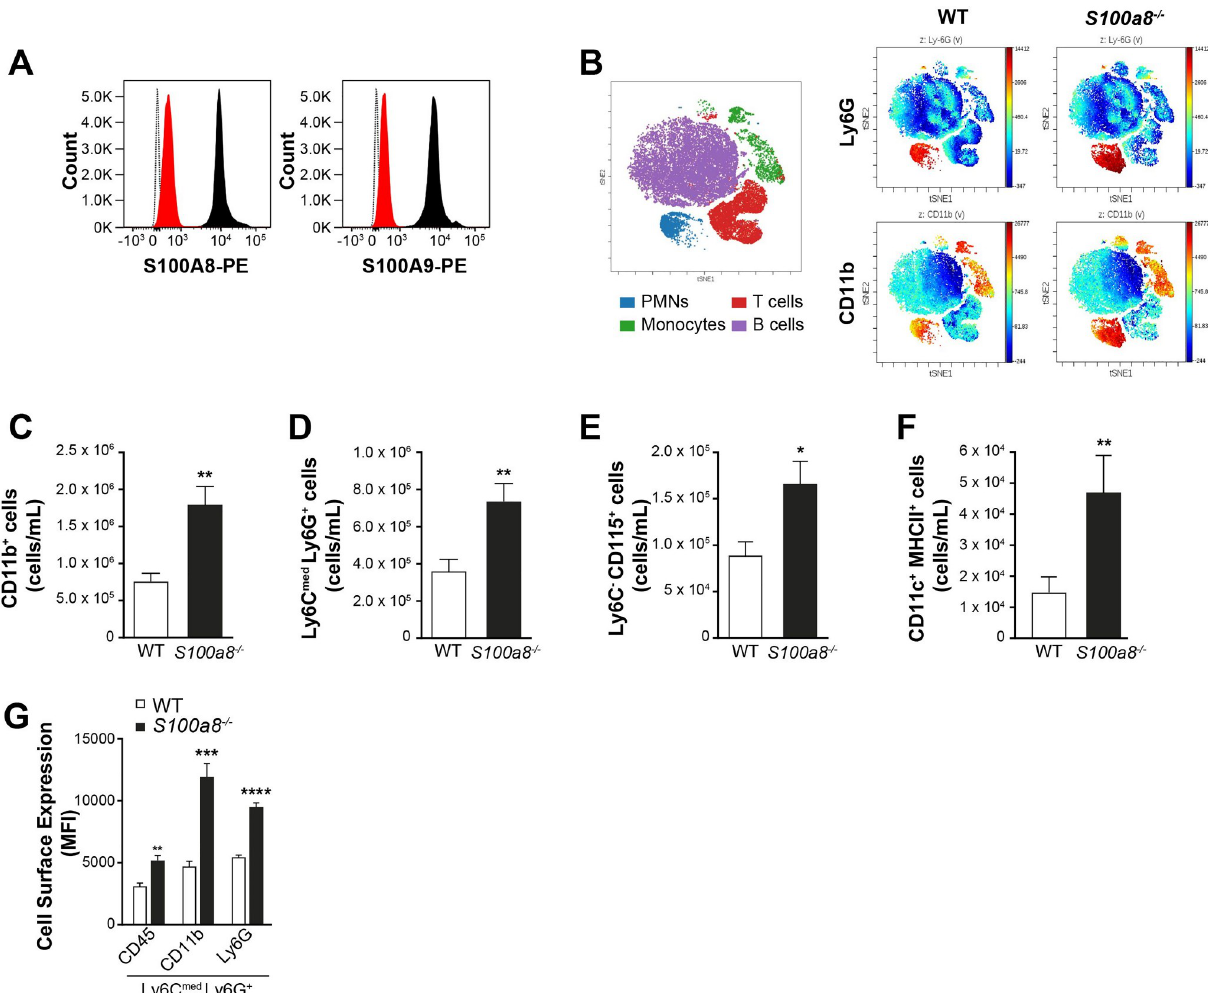
Fig 1. S100a8 -/- mice have increased circulating and mature myeloid cells. (A) Cytometry analysis of S100A8 and S100A9 expression in WT (black) and S100a8 -/- Ly6C med Ly6G + (red) blood cells. Dotted line: isotype control antibody in WT cells. Results are from 1 representative experiment (n = 3). (B) Visualization (viSNE) of CD11b and Ly6G expression in leukocyte populations in peripheral blood. Left: representation of cell population distribution, magenta for B cells, green for monocytes, red for T cells and blue for neutrophils. Right: CD11b and Ly6G expression intensity in the different cell populations in WT and S100a8 -/- mice. (C–F) Flow cytometry measurement of: (C) CD11b + myeloid cell counts in peripheral blood, (D) circulating Ly6C med Ly6G hi neutrophil counts, (E) circulating Ly6C hi Ly6G low monocyte counts, (F) circulating CD11c + MHCII + dendritic cells. (G) Surface expression of CD45, CD11b and Ly6G in neutrophils (based on 8 mice). All values are mean ± sem. � p < 0.05; �� p < 0.01; ��� p < 0.001; ��� p < 0.0001, Student’s t-test.